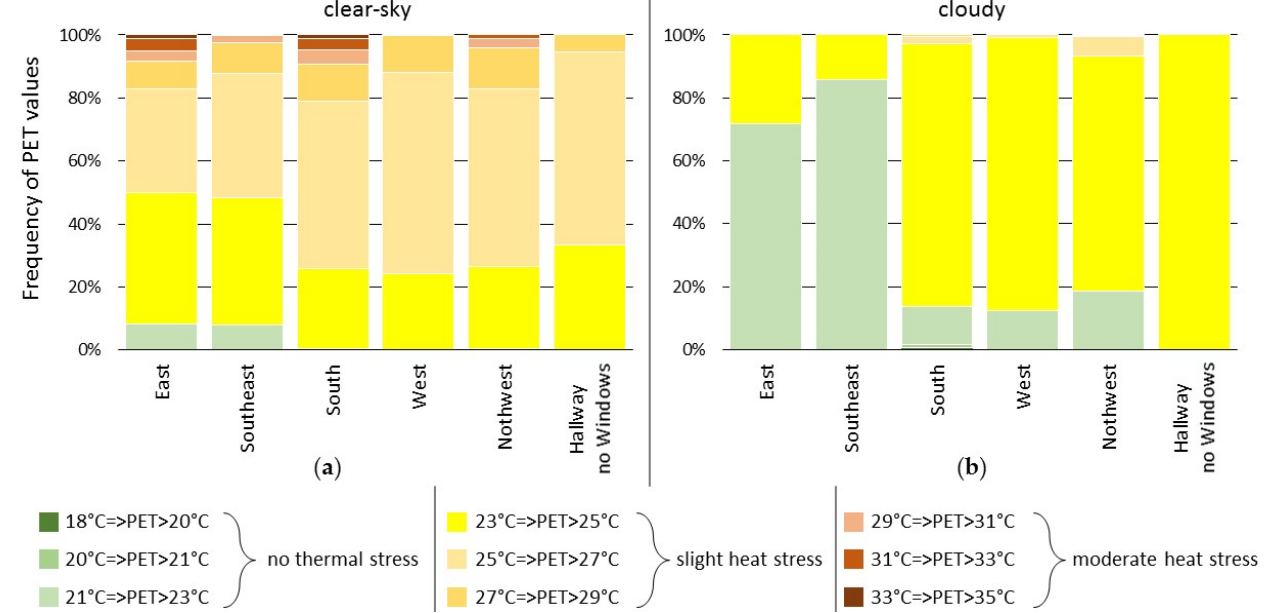
Figure 8. Distribution of physiologically equivalent temperature (PET) values measured by MoBiMets in the same office building in the city center of Freiburg with different exposures on the eighth floor: ( a ) during a clear-sky week between 2 September and 9 September 2021; ( b ) during cloudy days between 28 August and 31 August 2021.